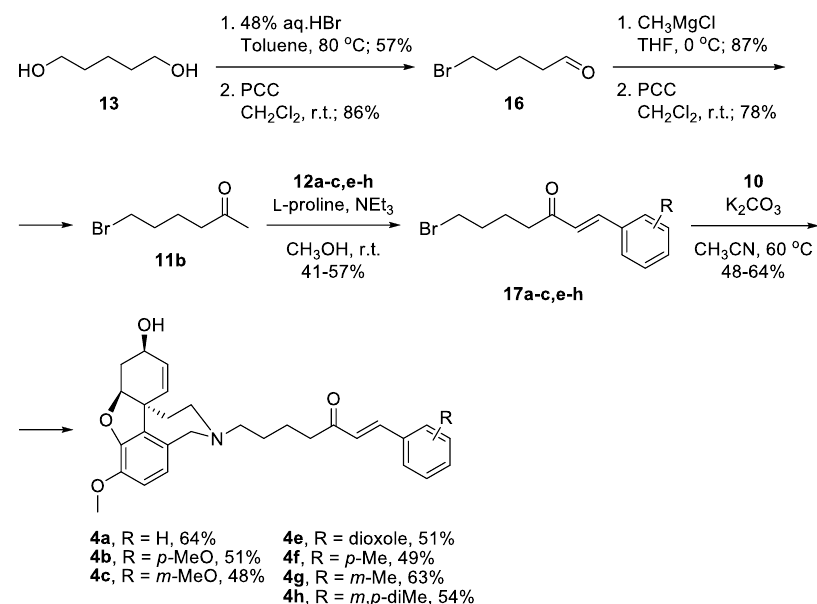
Figure 5. Retrosynthetic analysis of compounds 6a , b